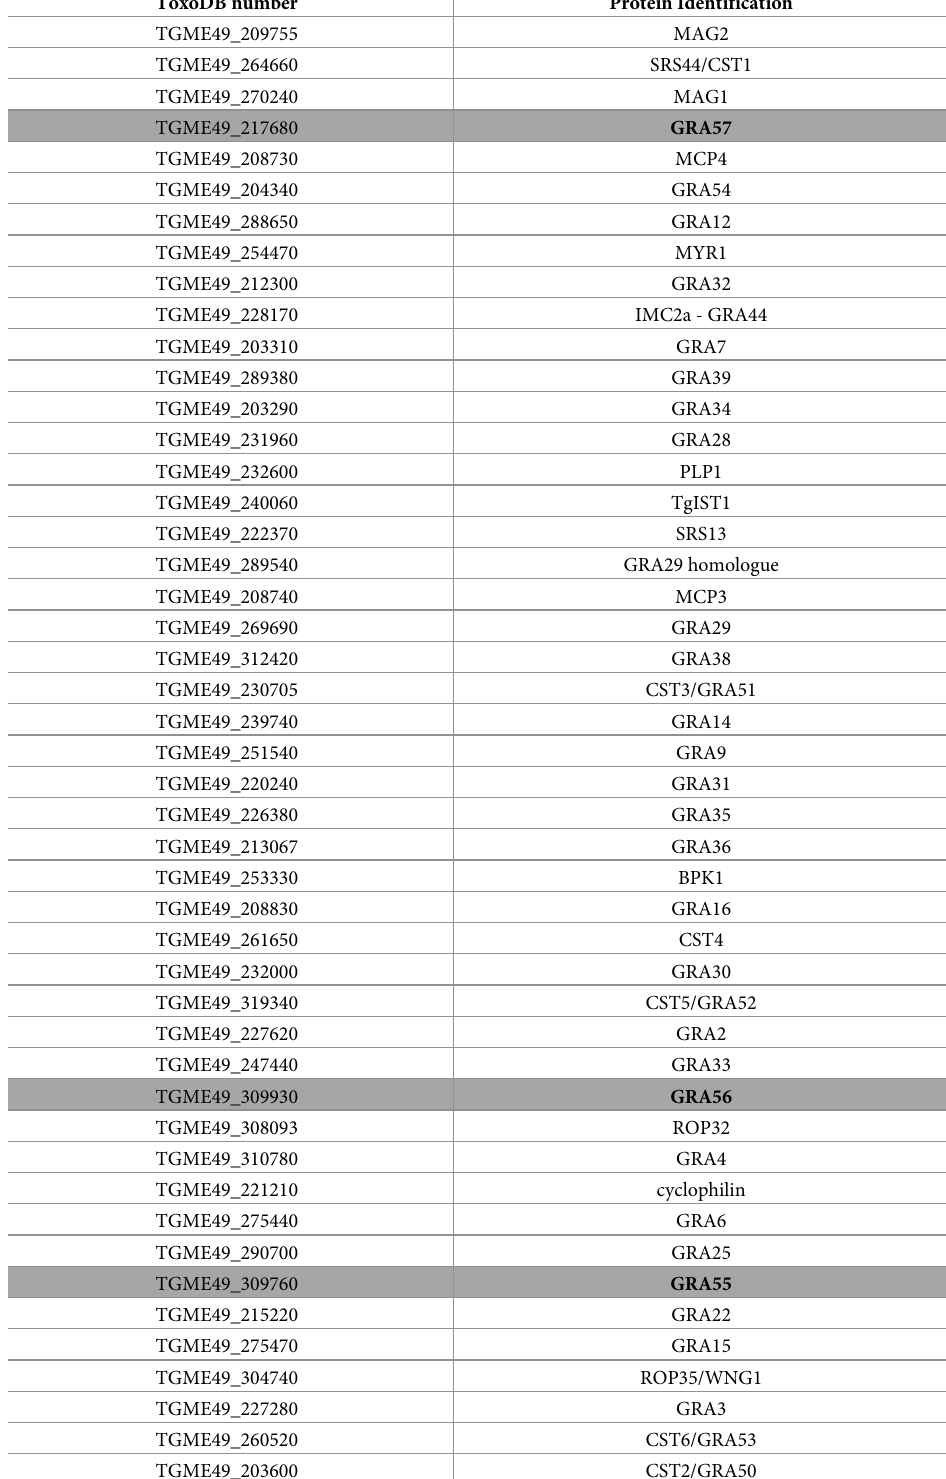
Table 1. Summary of known and novel GRAs found by